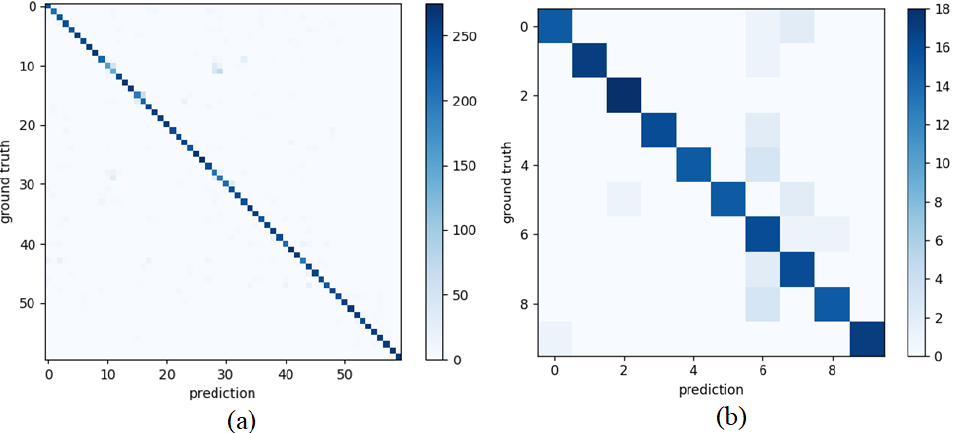
Figure 7. Confusion matrix of the ( a ) NTU-RGB+D 60 dataset and ( b ) Tai Chi dataset under CS